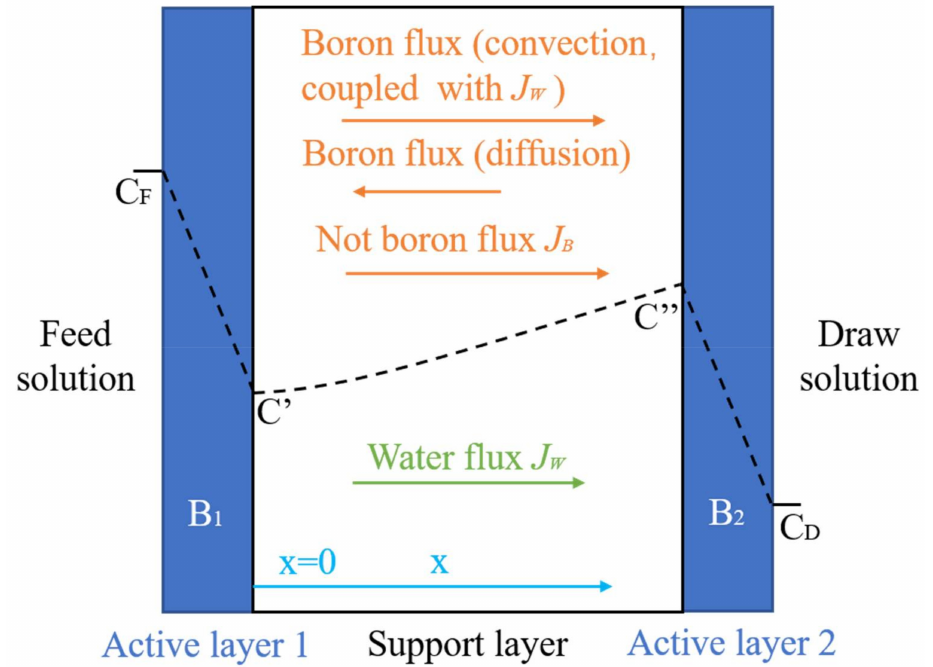
Figure 5. Transport of boron through the FO